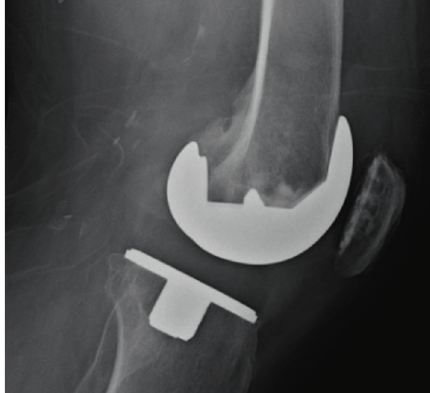
Figure 1: Lateral view of the left knee joint showing previous total knee replacement.